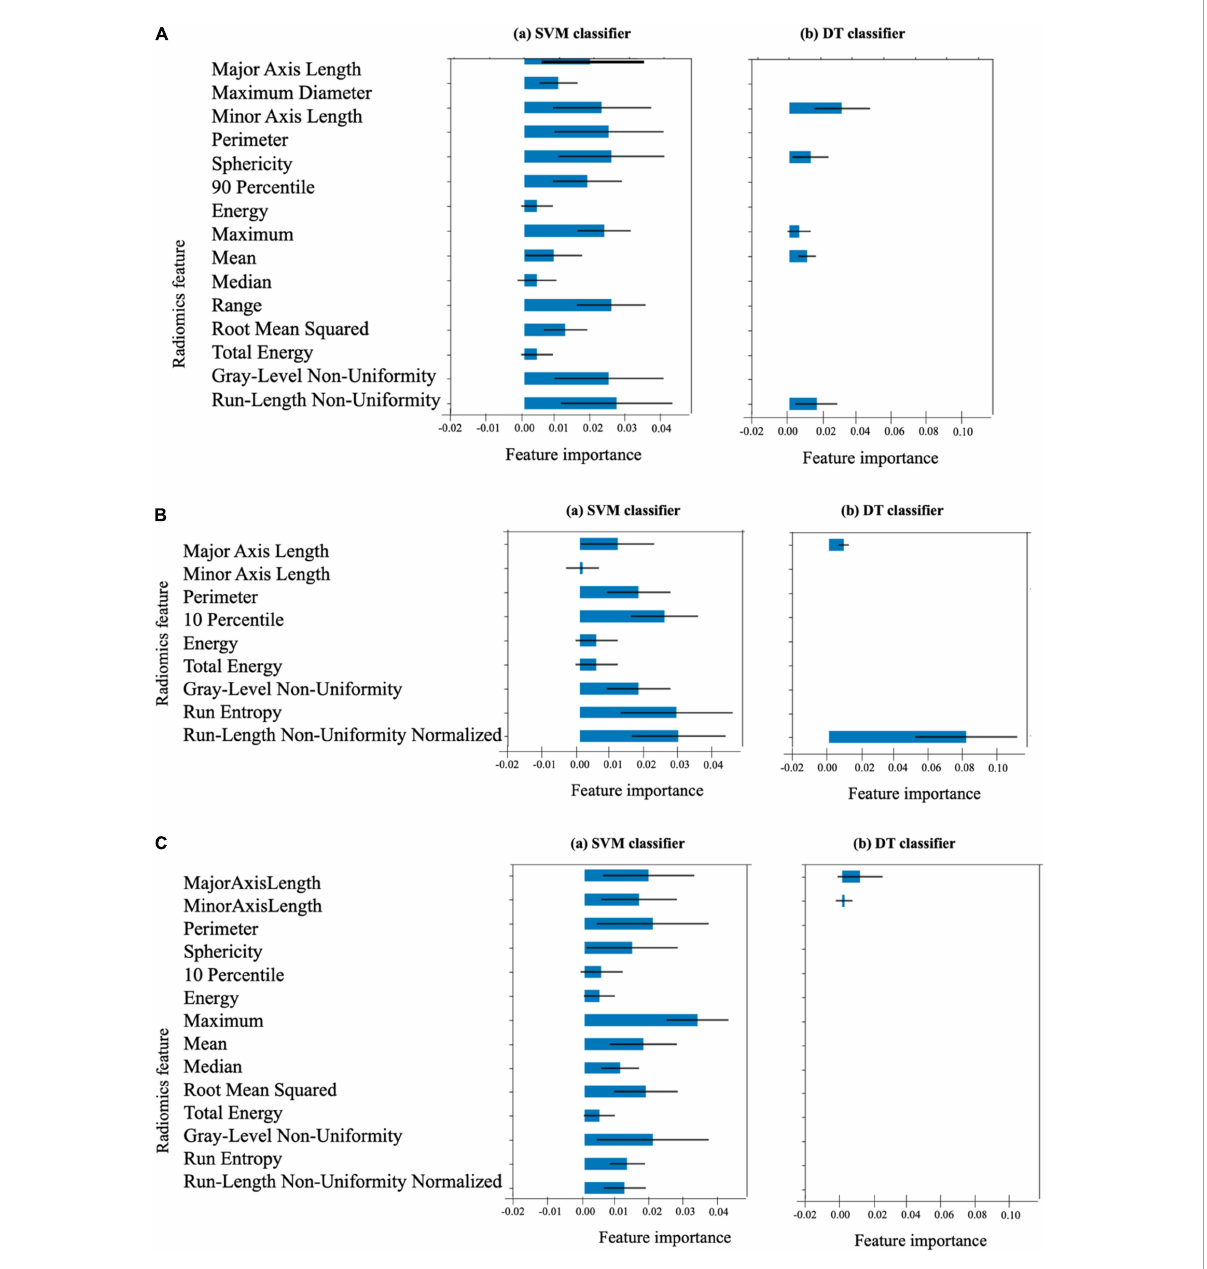
FIGURE10 Importance of the 38 radiomics features associated with (A) the end-systolic frame (15 features), (B) the end-diastolic frame (9 features), and (C) the middle frame (14 features) for the SVM and DT models. The length of the blue bar indicates the importance of the feature to the generalization power of the model (the black line is the ± SD). The DT classifier considers only the 9 features indicated as the only important features for its own